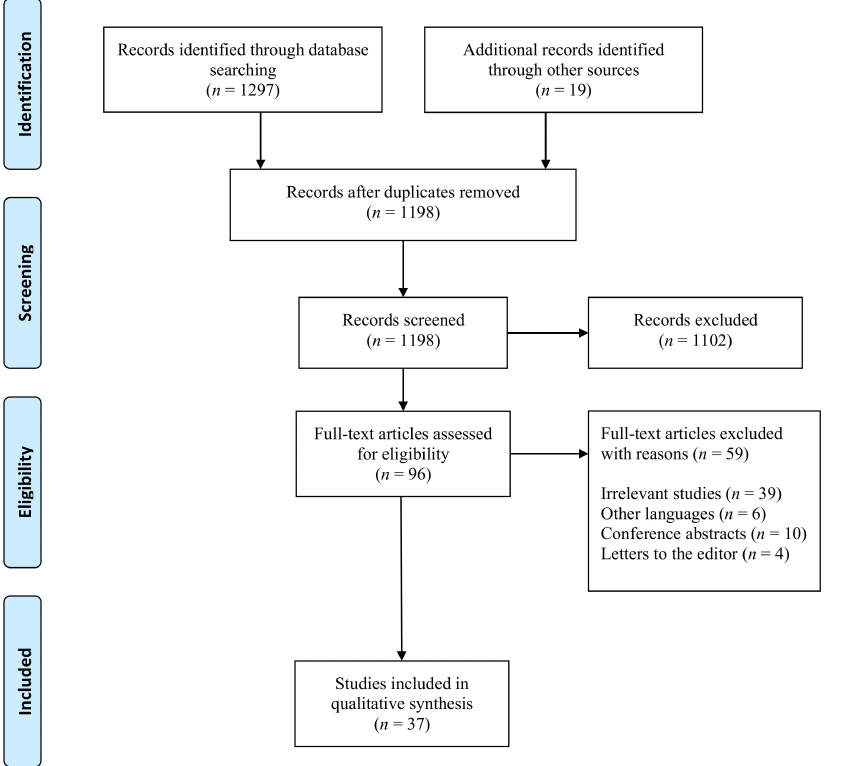
Figure 1. Flow diagram for study